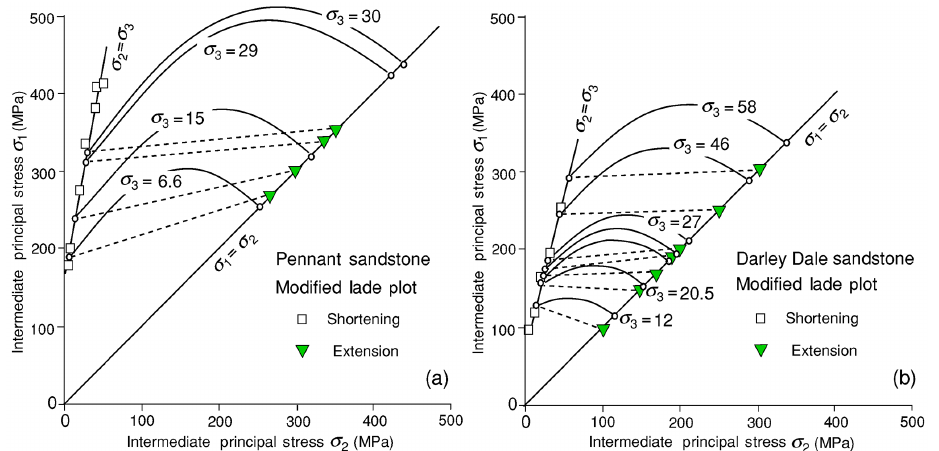
Figure 10. Test of how well the modified Lade polyaxial failure criterion predicts the results of extension tests from the Mohr–Coulomb description of the shortening tests for Pennant and Darley Dale sandstones. Dashed lines link experimental results for specific extension tests to the expected σ 1 values in shortening for the same value of σ 3 . For each such value of σ 3 (indicated) the expected failure point in extension is calculated (on the σ 1 = σ 2 line), plus the shape of the failure criterion for intermediate values of σ 2 . In both cases the modified Lade criterion overestimates the observed axisymmetric extension result for the higher values of σ 3 .